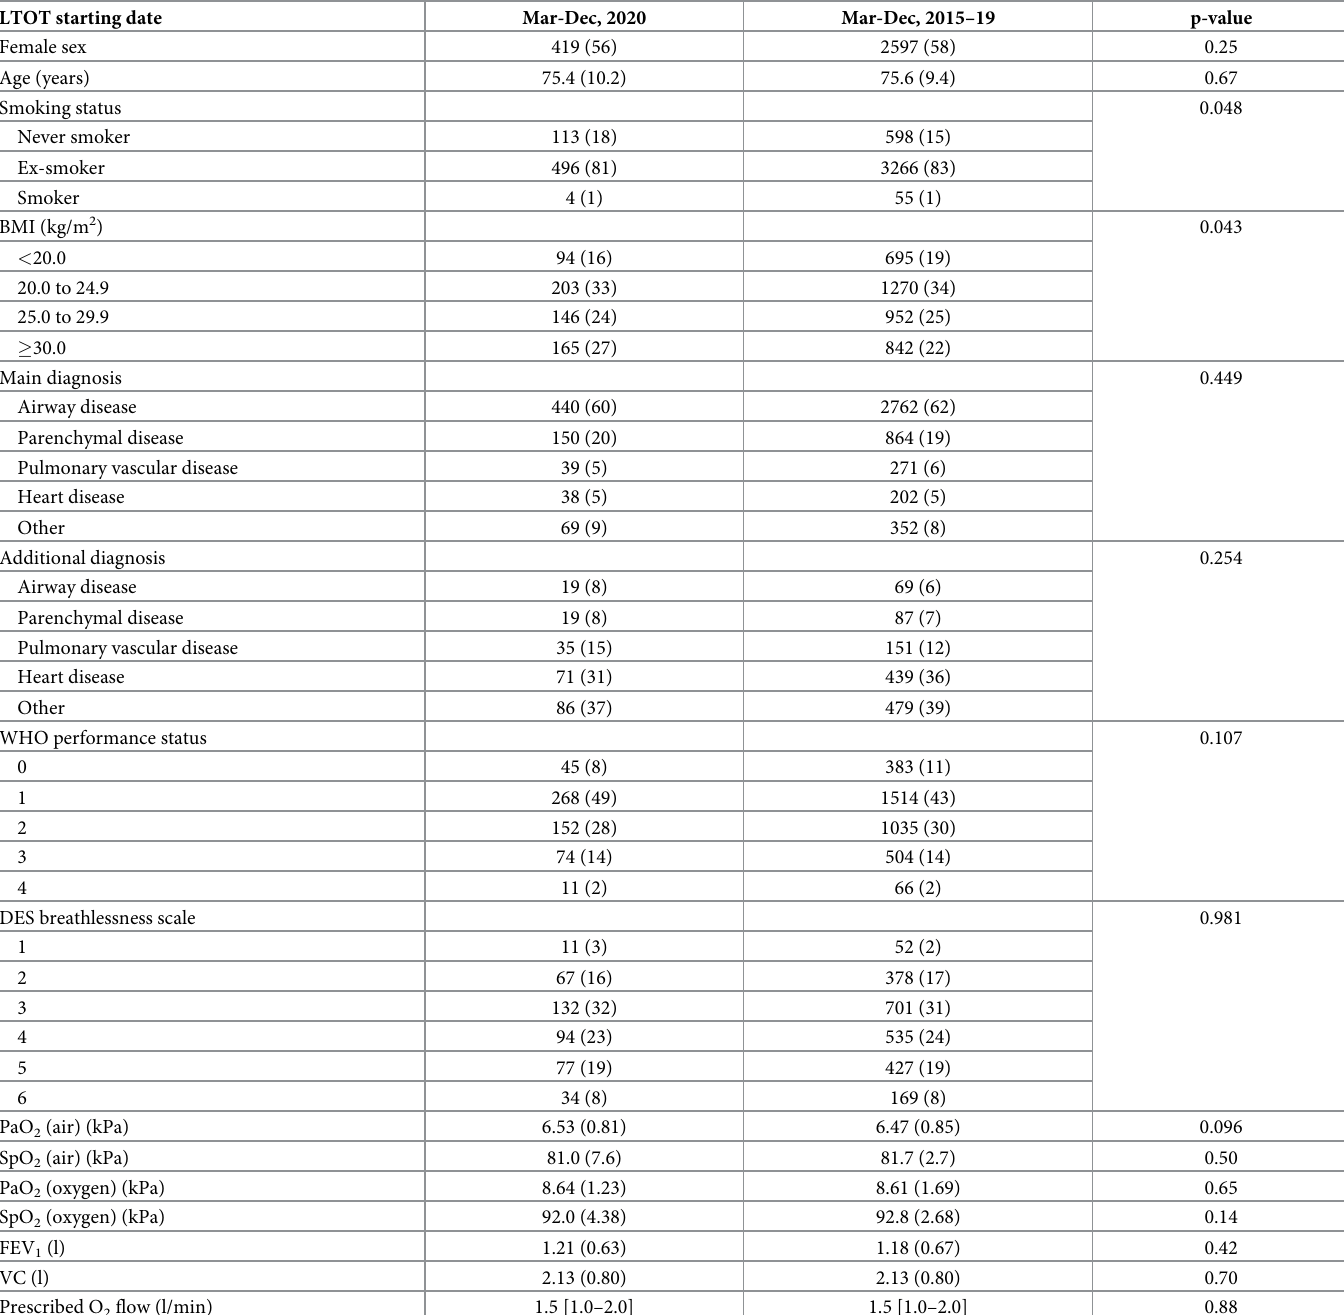
Table 1. Characteristics of patients starting LTOT in 2020 compared with previous five